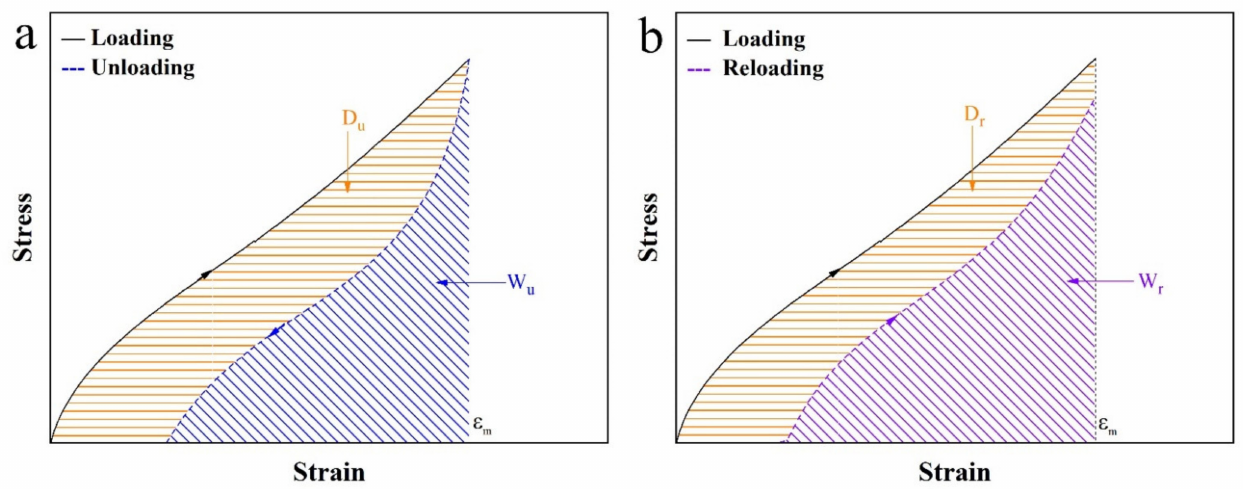
Figure 5. Schematics for the evaluations of energy dissipation based on ( a ) loading–unloading and ( b ) loading–reloading curves with the same maximum strain of ε m . W and D are the stored and dissipated energies, respectively. The subscripts u and r denote unloading and reloading, respectively.